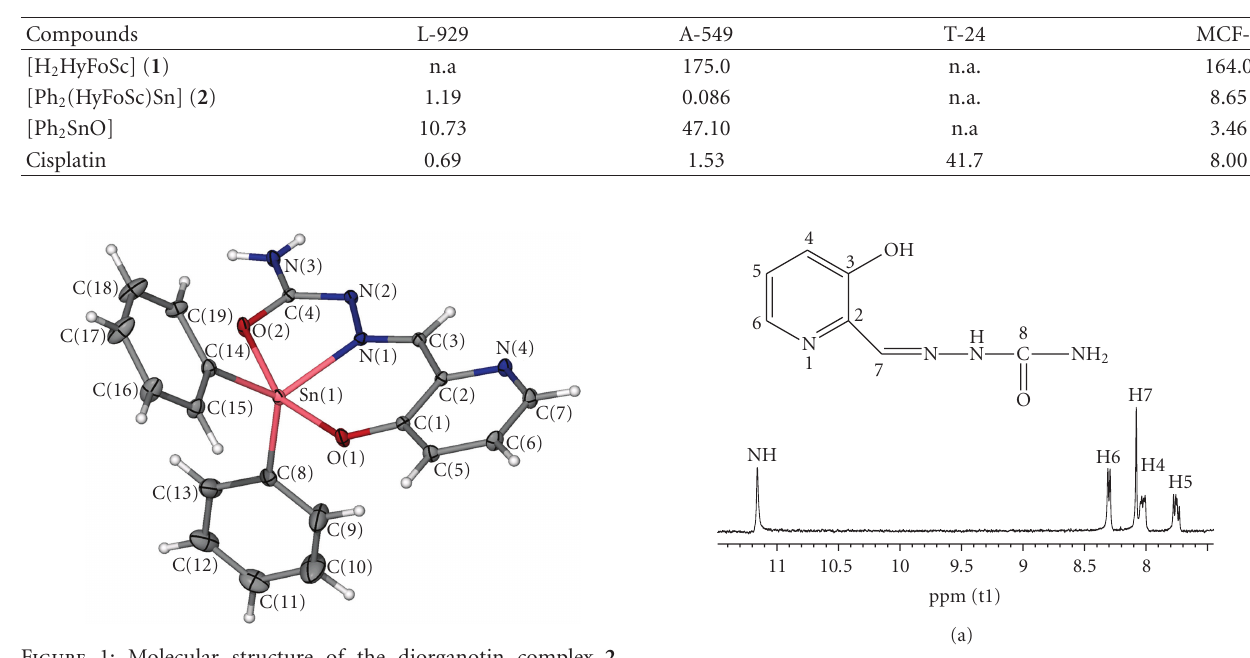
Figure 1: Molecular structure of the diorganotin complex 2 . Thermal ellipsoids are drawn at the 40% probability level.